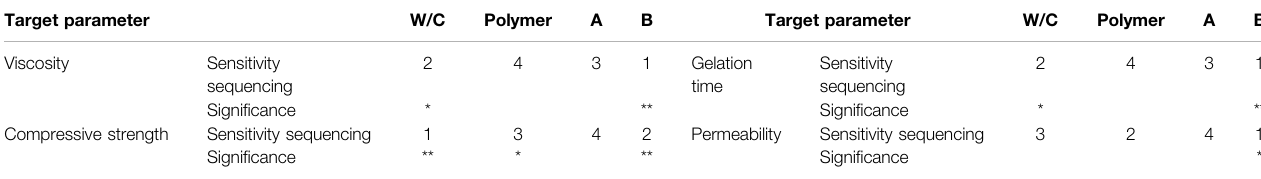
TABLE 3 | Range and variance analysis of orthogonal experimental results. Target parameter